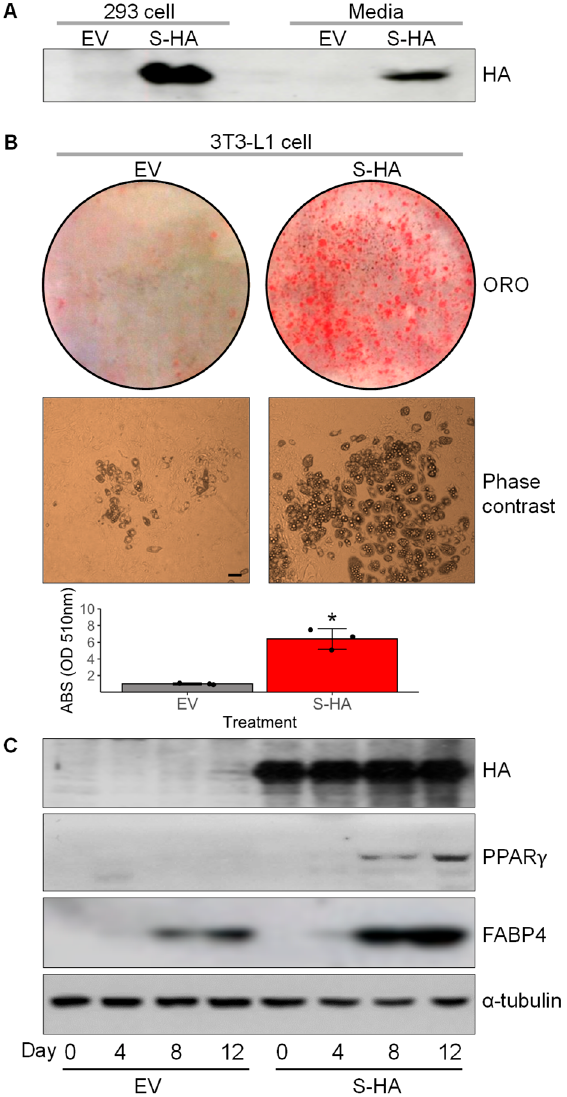
Figure 4. Effects of overexpression of Chrdl1 in adipogenic differentiation of 3T3-L1 preadipocytes. ( A ) Representative Western blots of HA-tagged CHRDL1 short-form (S-HA) in 293 cell lysates and culture media after transfection. The experiment was performed in triplicate. ( B ) Oil Red O staining and phase-contrast images of S-HA overexpressing 3T3-L1 cells. For quantification, absorbance (ABS) was measured for the ORO-stained lipid droplets at 510 nm. Values are the mean ± SEM of three independent experiments. *, p < 0.05. ( C ) Representative Western blots of overexpressed S-HA protein detected against an anti-HA tag antibody and positive markers of adipogenic differentiation and lipid accumulation (PPAR γ and FABP4) in 3T3-L1 cells. The experiment was conducted in duplicate. Cell lysates were collected at day 0, 4, 8, and 12 after induction of adipogenic differentiation. The α -tubulin protein was used as a loading control. EV, empty vector that was transfected as a control. The scale bar indicates 100 µ